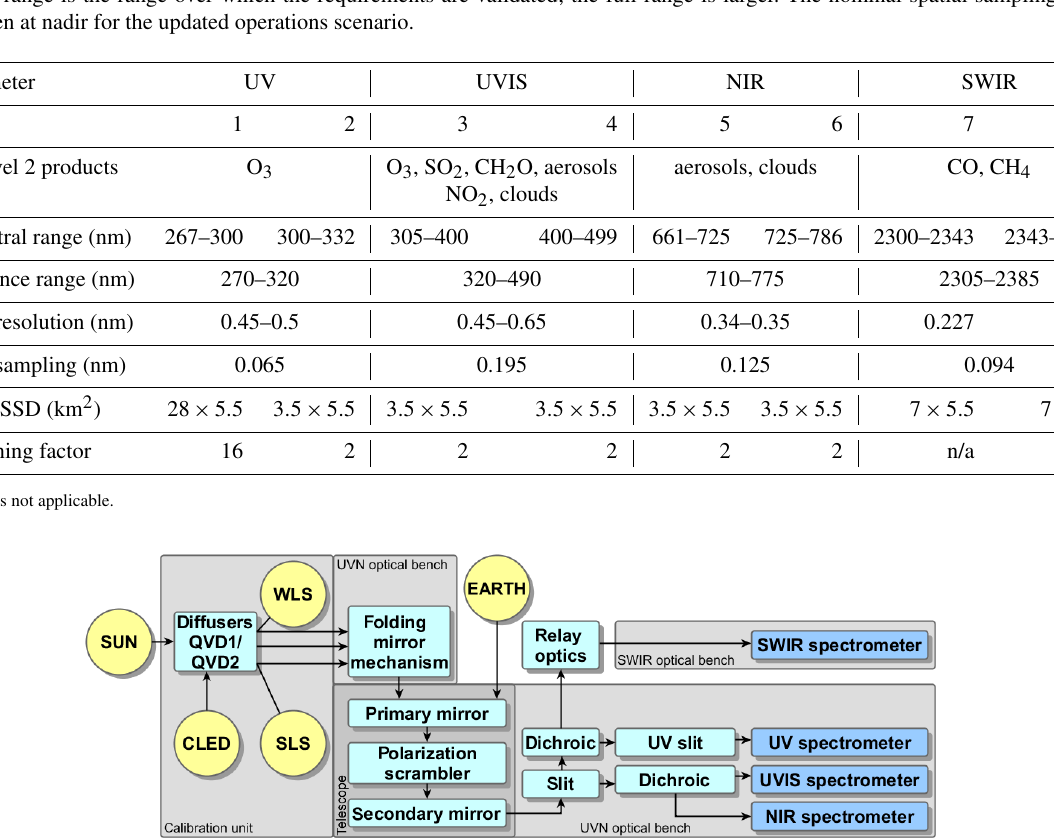
Figure 1. Functional diagram of the TROPOMI instrument. When the folding mirror is open, light from Earth enters the instrument’s telescope. At the instrument slit, light for the UV and SWIR spectrometers is reflected, while it is transmitted for the UVIS and NIR spectrometers. Dichroic mirrors split the light further to the respective spectrometers. The SWIR spectrometer is housed in a separate optical bench connected by relay optics. When the folding mirror is closed, light can enter from the calibration unit. Light from the internal white- light source (WLS) and the spectral-line source (SLS) is reflected off the sides of the diffusers, while light from the common LED (CLED) or the Sun passes through either of the two quasi volume diffusers (QVD1 and